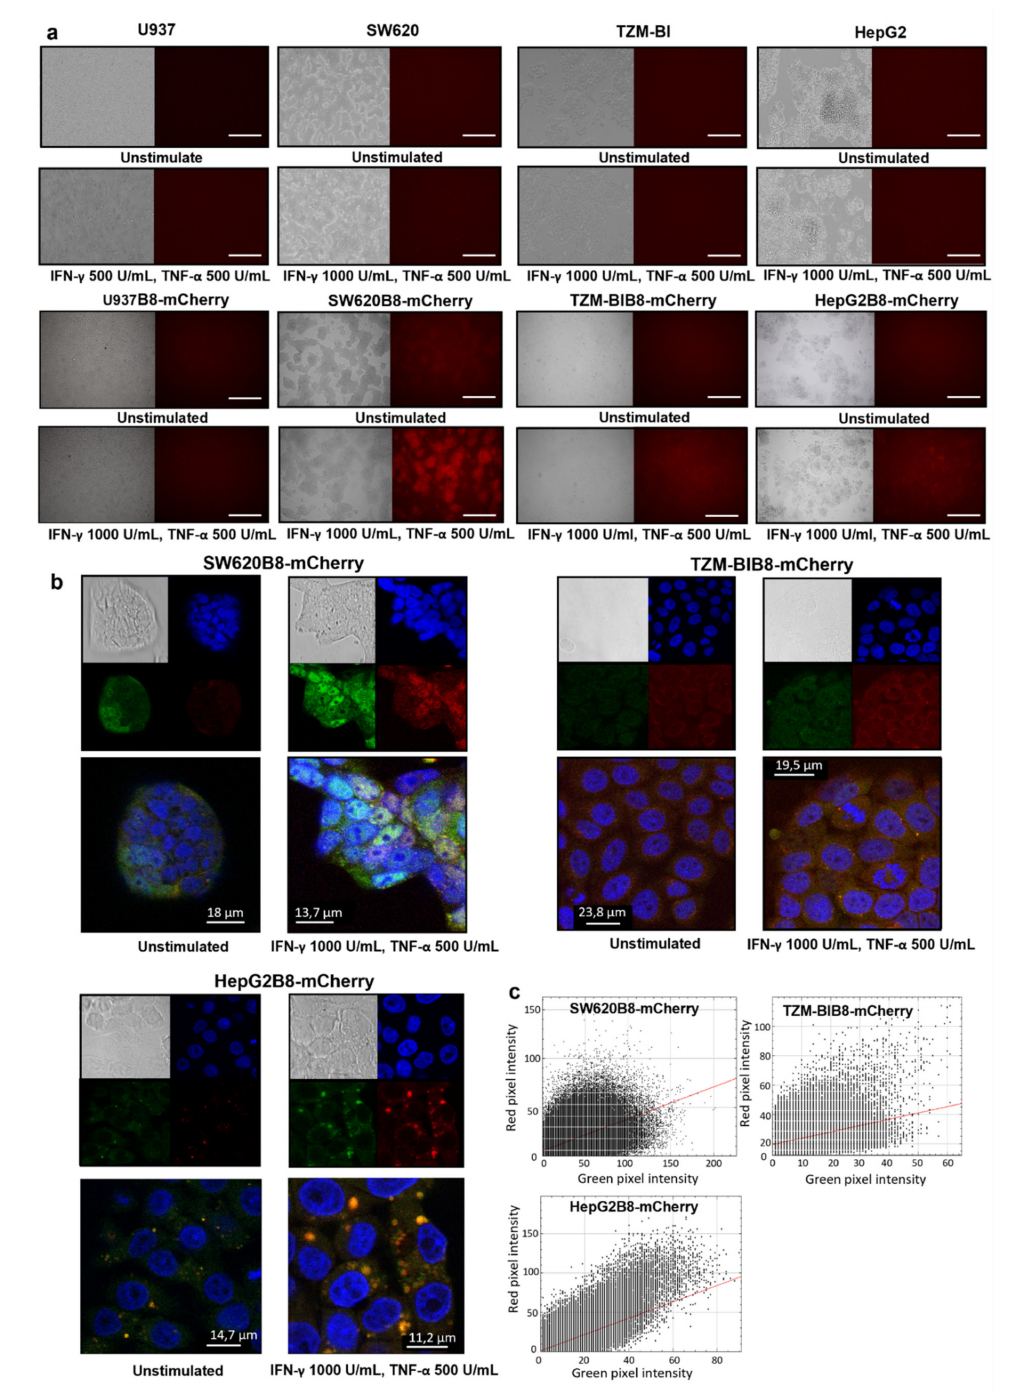
Figure 3. Proteasomes with β 5i-mCherry subunit are localized in the nucleus and cytoplasm of modified cells. ( a ) Fluorescent microscopy of unstimulated as well as of U937, SW620, TZM-bl, HepG2, U937B8-mCherry, SW620B8-mCherry, TZM-blB8- mCherry and HepG2B8-mCherry cells treated with IFN- γ (1000 U/mL) and TNF- α (500 U/mL) for 72 h. White scale bar—400 µ m. ( b ) Confocal microscopy of unstimulated and cytokine-stimulated (1000 U/mL IFN- γ and 500 U/mL TNF- α ) SW620B8-mCherry, TZM-blB8-mCherry and HepG2B8-mCherry cells. mCherry fluorescence is shown in red. Additionally, cells were incubated for 2 h with Me4BodipyFL-Ahx3Leu3VS (green fluorescence) to localize proteasome activity within the cells. Cell nuclei were stained with NucBlue Fixed Cell ReadyProbe (blue fluorescence). Proteasomes were revealed in the nuclei and cytoplasm of the inspected cells. Moreover, areas with intense proteasome fluorescence were observed within the cellular cytoplasm. ( c ) Scatterplots of green (BodipyFL) and red (mCherry) pixel intensities of the modified cells treated with IFN- γ (1000 U/mL) and TNF- α (500 U/mL) for 72